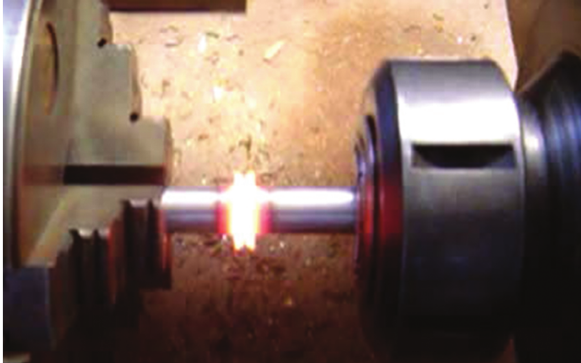
Figure 3: The specimens are joining by friction welding machine.